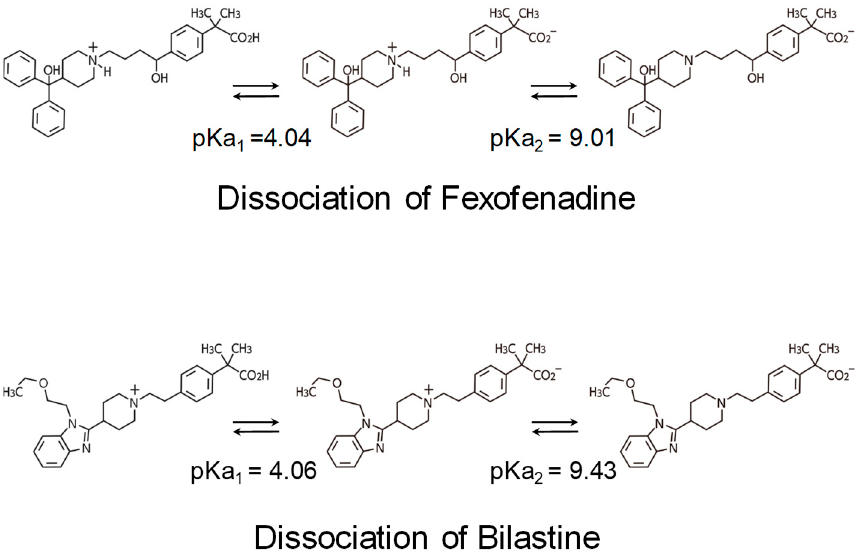
Figure 5. Acid–Base Dissociation Constant (p K a). Non-sedating antihistamines of the carboxy group type have zwitterionic properties with positive and negative charges at two sites. The p K a of bilastine and fexofenadine are nearly the same, and these drugs are mostly dissociated at the physiological pH, making them difficult to penetrate into the brain. Non-sedating antihistamines are not potent inhibitors of P-glycoprotein; therefore, they are considered not to penetrate into the brain because of complex reasons, including molecular weight and p K